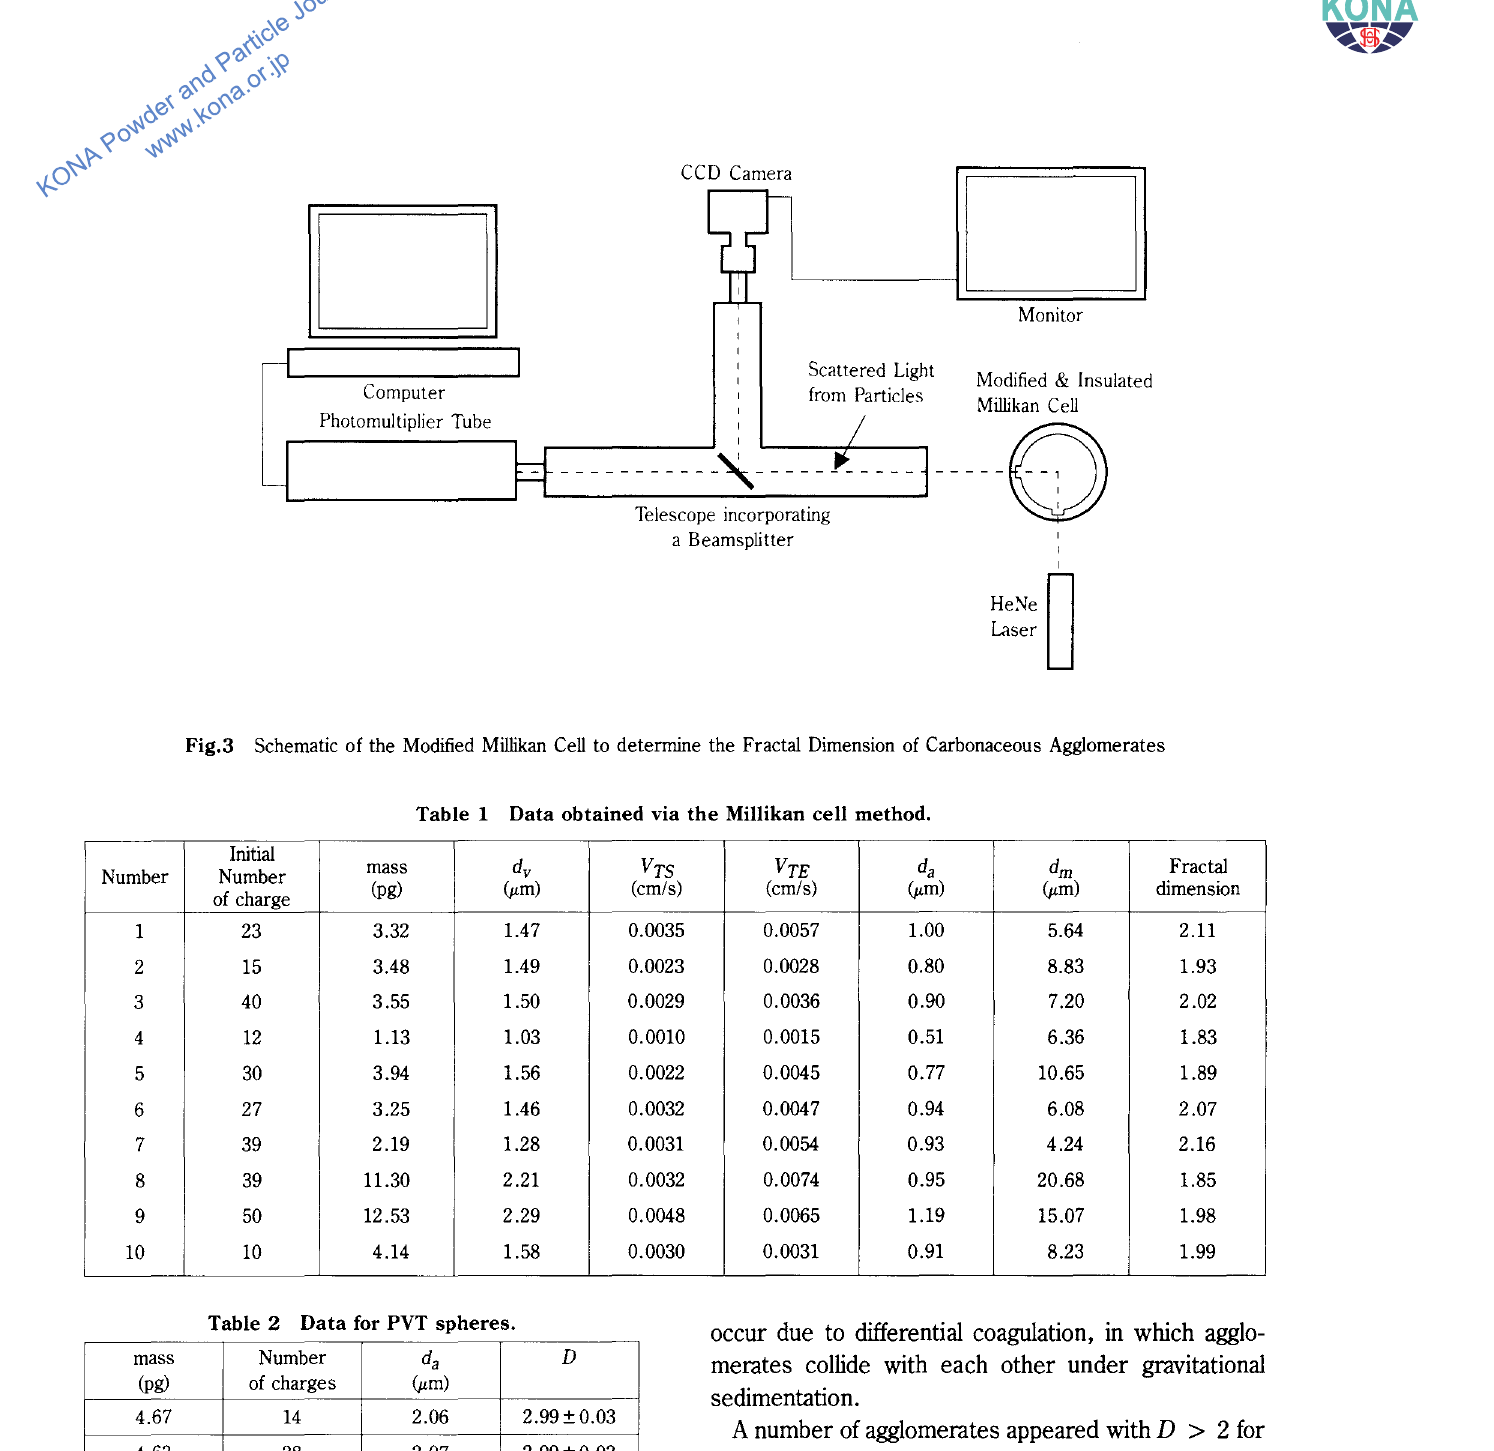
Table 2 Data for PVT